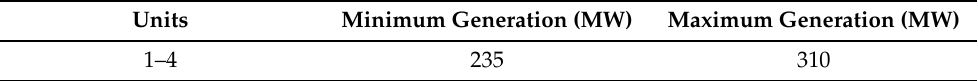
Table 1. Bounds on generation for the units of Salto Caxias. The data is taken from the system operator’s publicly available archives